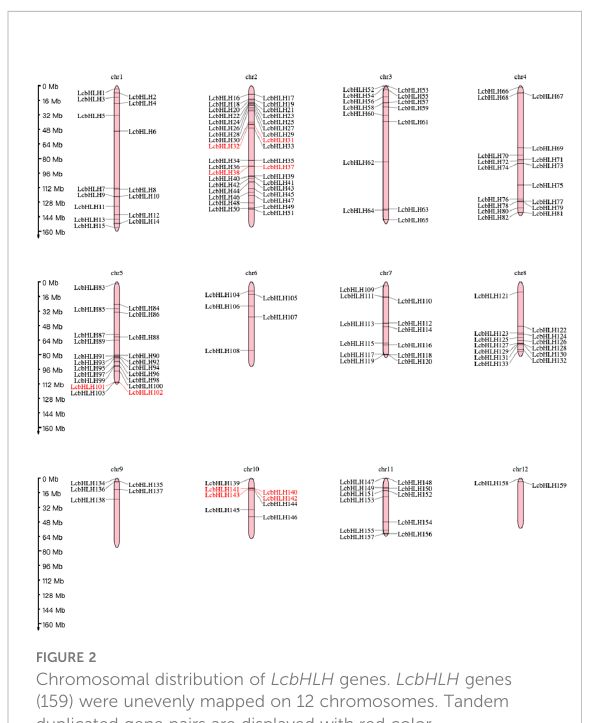
FIGURE 3 Collinearity analysis of LcbHLH genes. Circle plot created using the MCScanX tool. Collinear genes are linked by colored